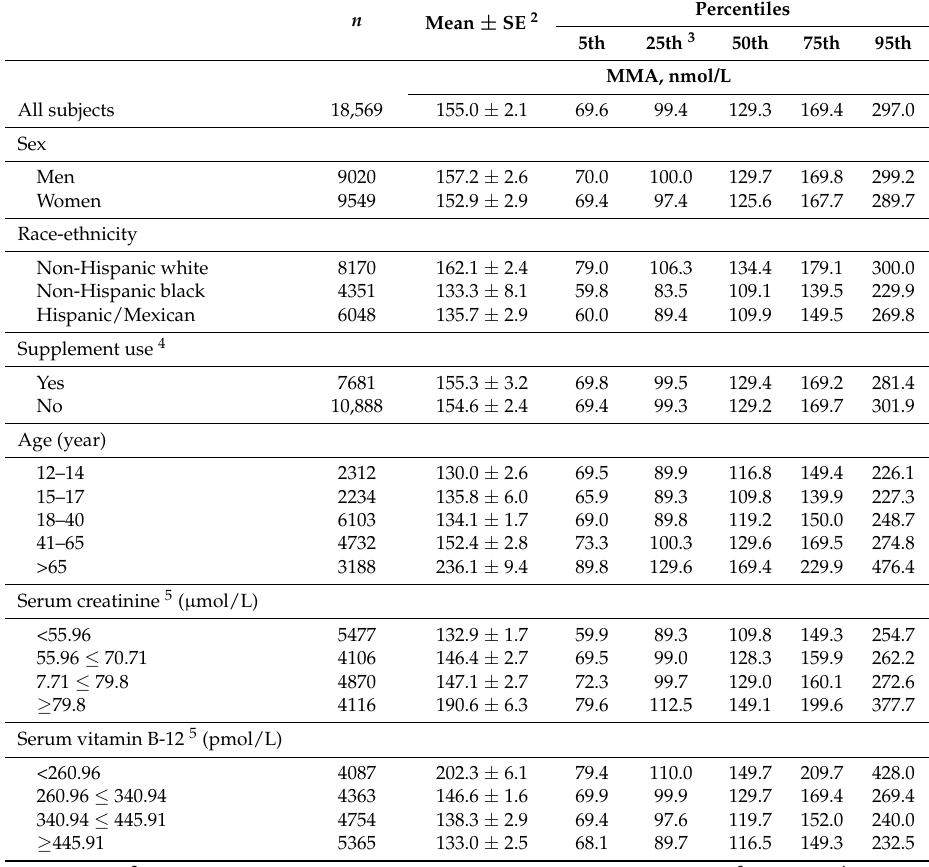
Table 2. Population reference values for serum methylmalonic acid (MMA) concentrations in the US population: data from the National Health and Nutrition Examination Survey, 1999–2004 1 .